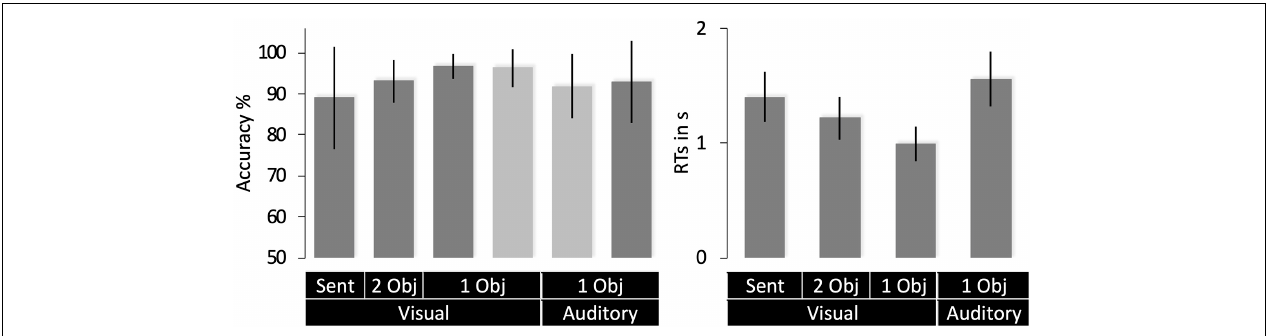
FIGURE 4 | Behavioral data (mean with SD). Accuracy scores for Group 1 are shown in light gray and Group 2 in dark gray. RTs (right) were only available for Group 1. 1 Obj = single object naming, 2 Obj = two-object naming, Sent = sentence production. RTs are for correct trials